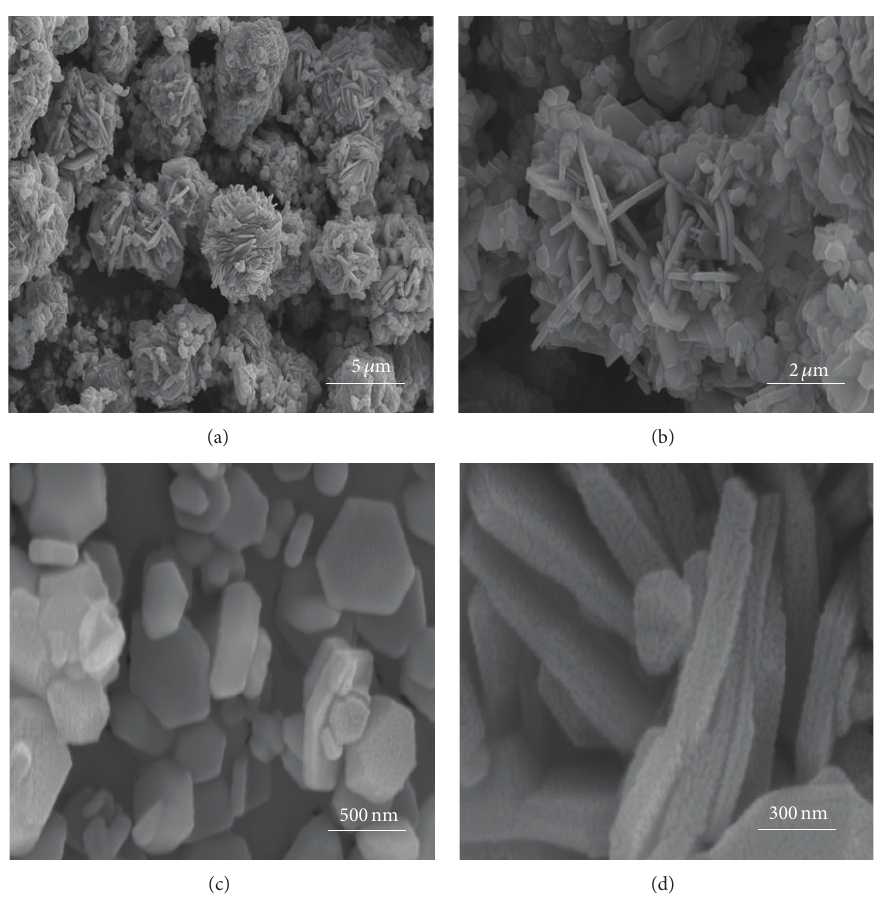
Figure 4: FE-SEM images of CuS nanostructures with CTAB at 150 ∘ C for 24 hrs at different magnifications.